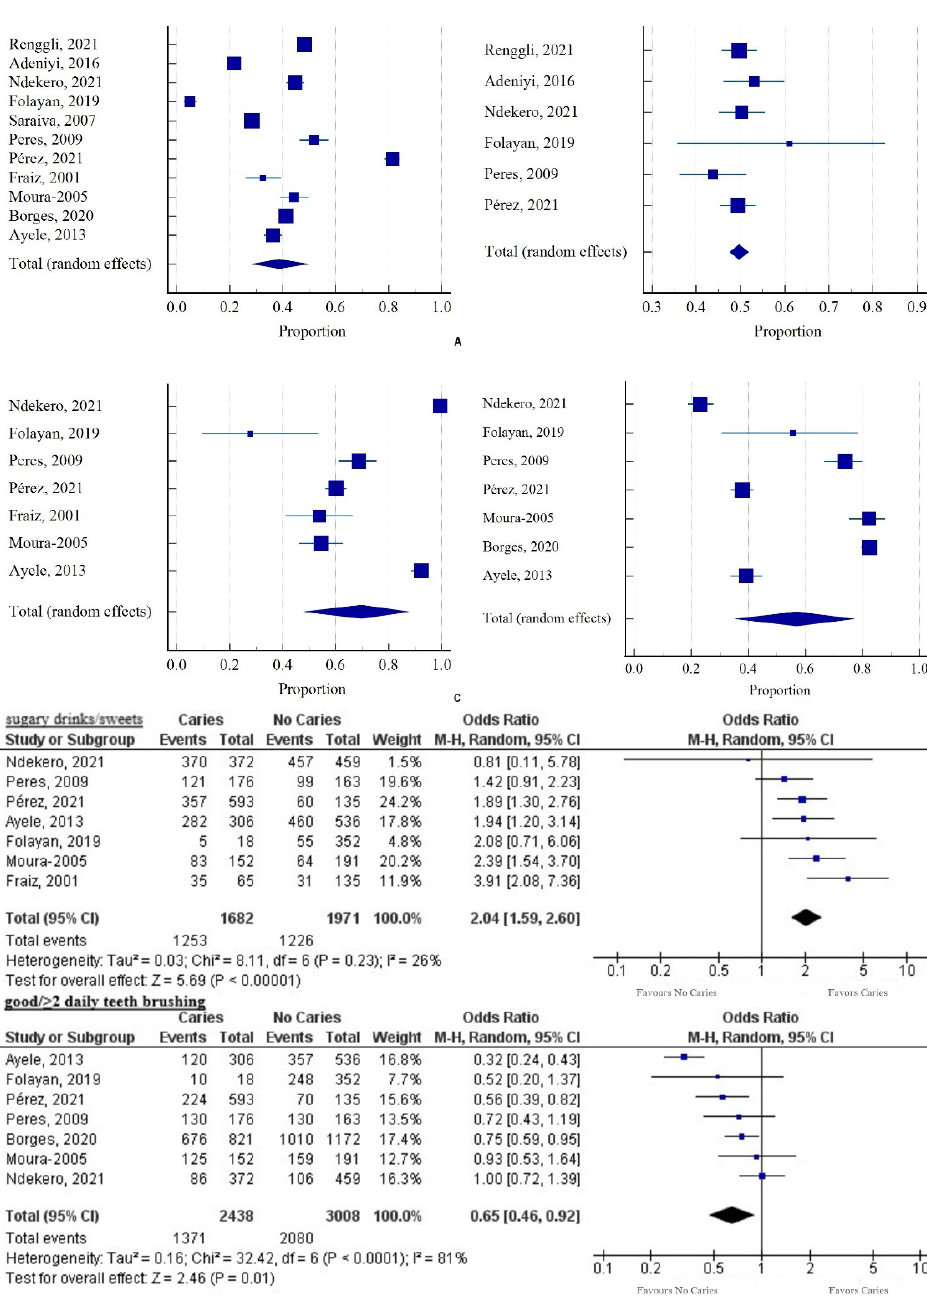
Figure 2. ( A ) Pooled prevalence of dental caries (N = 4250) in the total population (N = 11,115); ( B ) Pooled prevalence of females (N = 993) in the population with caries (N = 1999); ( C ) Pooled prevalence of sugary drinks/sweets consumption (N = 1253) in the population with caries (N = 1682); ( D ) Pooled prevalence of good brushing habits /≥ 2 daily teeth brushing (n = 1371/2438) in the population with caries, presented as a proportion in a forest plot, applying the random-effects model; ( E ) Sugary drinks/sweets consumption: a forest plot depicting the odds ratio (OR) of children having caries compared to no caries. Heterogeneity: Tau 2 = 0.03; Chi 2 = 8.11, DF = 6; I 2 = 26%. Test for overall effect: Z = 5.69 ( p < 0.00001); ( F ) Post good / ≥ 2 daily teeth brushing: a forest plot depicting OR of children with caries compared to no caries. Heterogeneity: Tau 2 = 0.16; Chi 2 = 32.42, DF = 6 ( p < 0.0001); I 2 = 81%. Test for overall effect: Z = 2.46 ( p = 0.01).